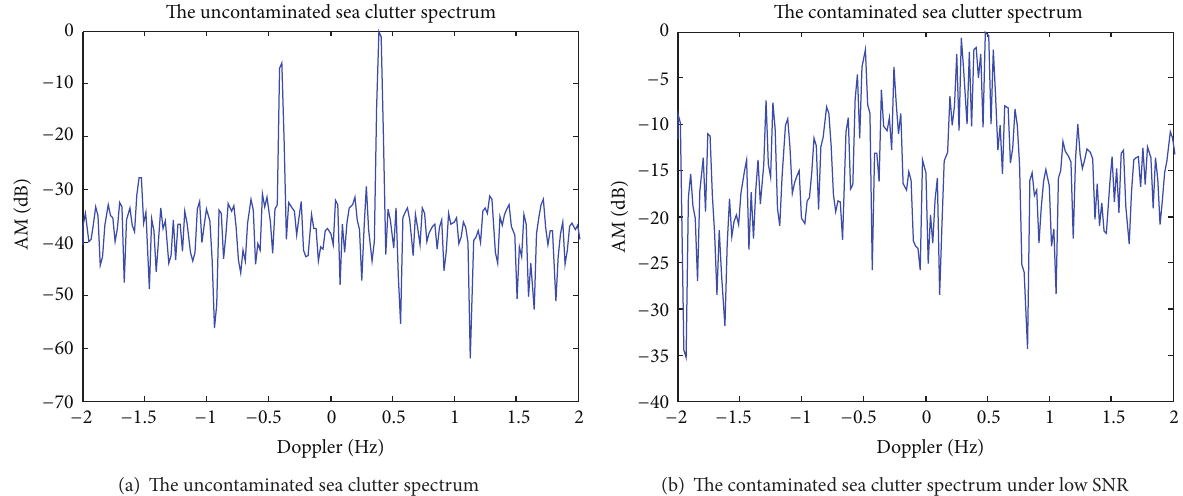
Figure 5: The uncontaminated and the contaminated sea clutter spectra under low